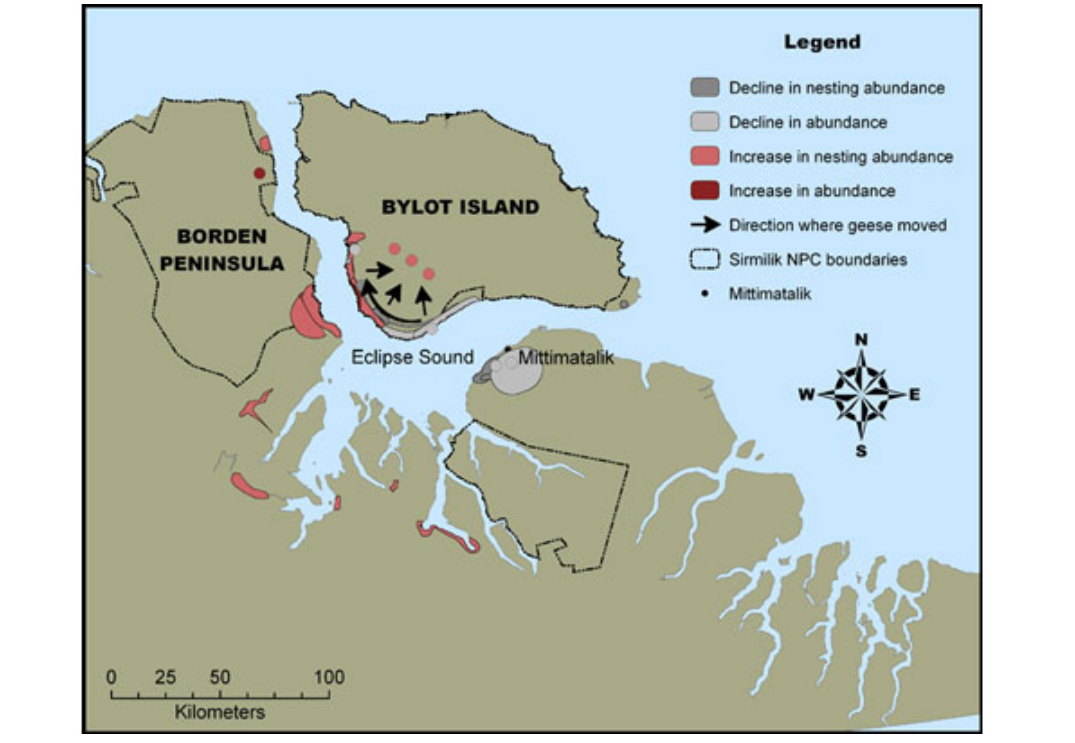
Fig. 7 . Changes in the abundance and distribution of greater snow geese ( Chen caerulescens atlantica ), as reported by the local experts from Mittimatalik, Nunavut, Canada, interviewed in this study. The temporal scale includes knowledge dating back to the 1940s, and the spatial scale is Bylot Island and the northern part of adjacent Baffin Island. Black arrows indicate the movements of geese toward higher ground and the western side of the south plain of Bylot